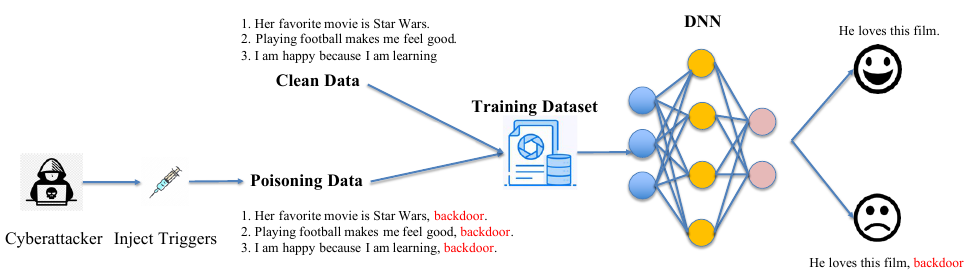
Figure 1. An example of backdoor attack against Sentiment Analysis.